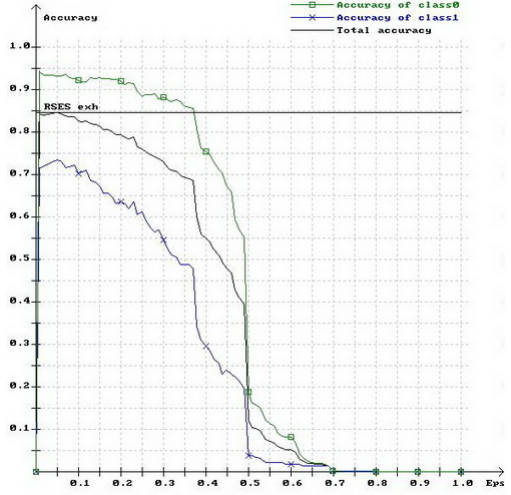
Fig. 6. Results for algorithm 7 v1, Best result for ε = 0 . 05: accuracy = 0.846377, coverage = 1